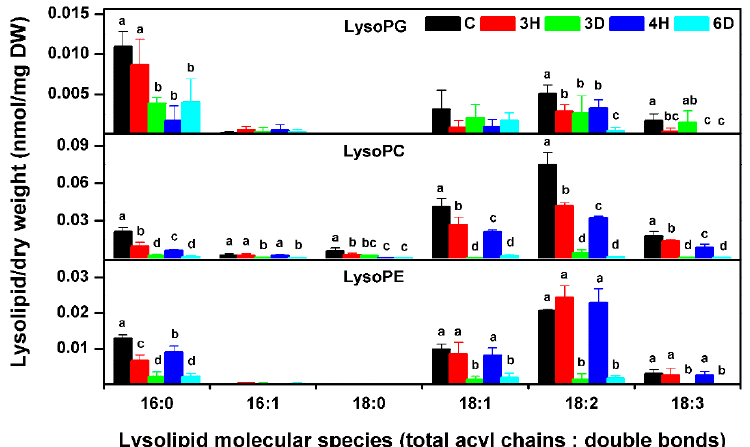
Figure 10. Lyso-phospholipid molecular species contents in the A. thaliana seeds during the hydration–dehydration cycles. The treatment was the same as that described in Figure 3. DW, dry weight. Each value is mean ± SD ( n = 4 or 5). Bars for the same molecular species with different letters indicate that the values were significantly different ( p < 0.05).